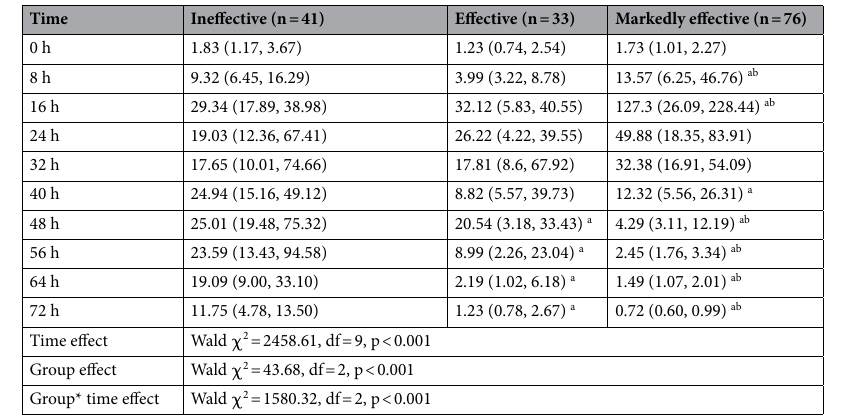
Table 2. Plasma D-dimer levels of patients. Data expressed as median (IQR). Generalized estimating equations models base on gamma distribution were performed. a p < 0.05 compared with ineffective group at the same time point. b p < 0.05 compared with effective group at the same time point.